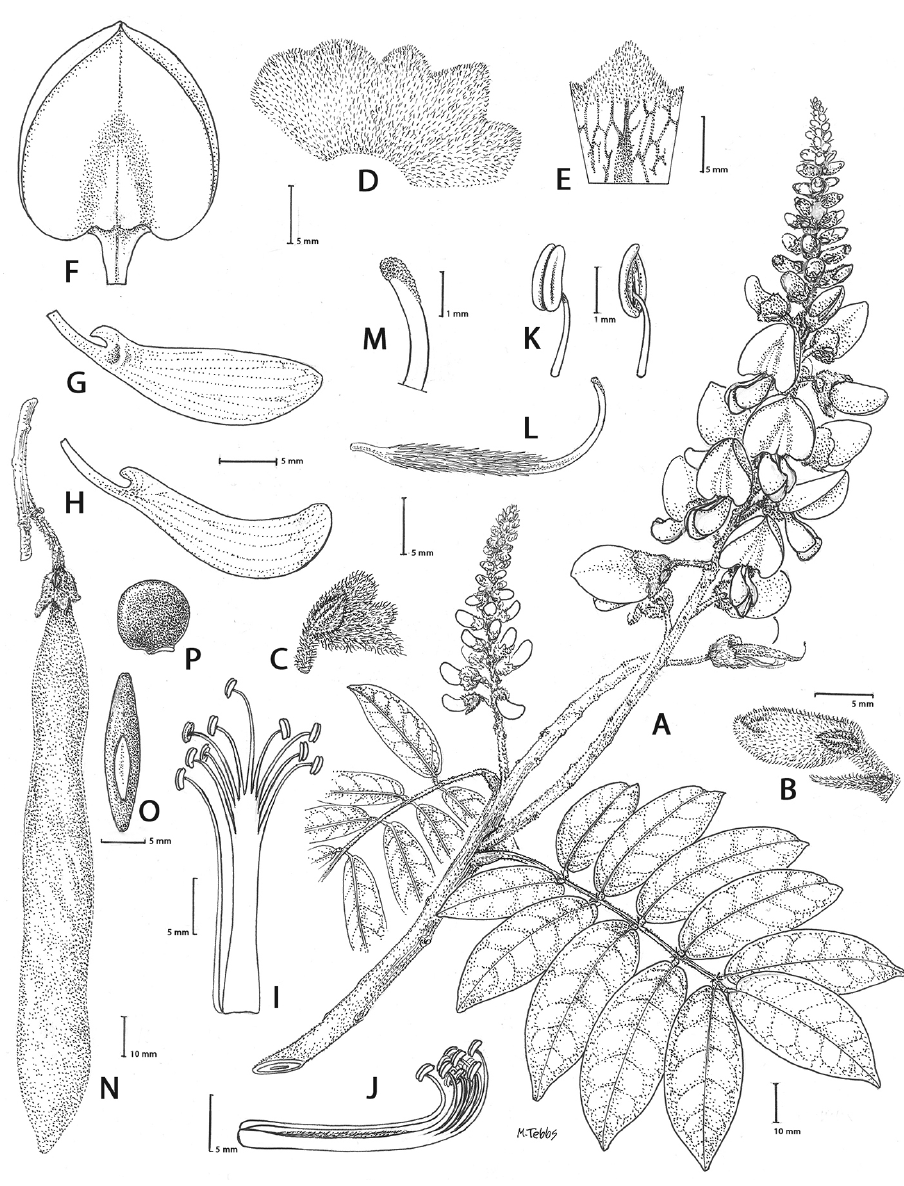
Figure 4. Nanhaia speciosa (Champ. ex Benth.) J.Compton & Schrire. A Habit B flower bud with bract and bracteole C calyx exterior and bracteole D detail of calyx exterior E detail of calyx interior F standard petal G wing petal H keel petal I staminal column J staminal column lateral view K stamen ventral and dorsal view L ovary and style M style and stigma N pod O seed lateral view P seed ventral view (all from Shiu Ling Hu 6091). Drawn by Margaret